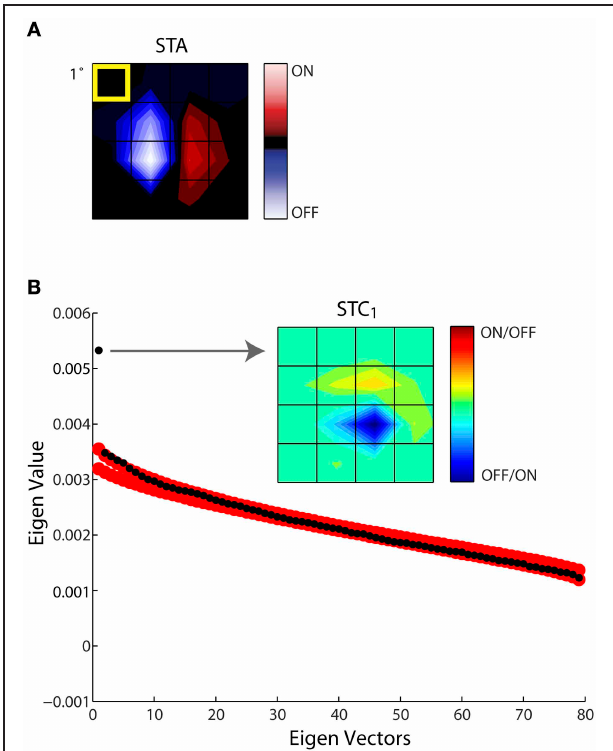
FIGURE 4 | Establishing the significance of the filters obtained with STC. (A) STA recovered for a sample cell, shown as 4 × 4 window of the entire stimulus grid. (B) Principal component analysis of a (4 × 4 × 5) spike-triggered stimulus ensemble yielded 80 eigenvalues (black dots) plotted in descending order. Only one point fell above the upper or lower bounds of the 99% confidence interval determined from eigenvalues obtained from 1000 iterations of a nested bootstrap (red dots); the corresponding subunit is indicated by the arrow. A separate color code is used for maps obtained using STC since this method does not specify which subregions are On vs. Off. The eccentricity of the receptive field was 10.3 ◦